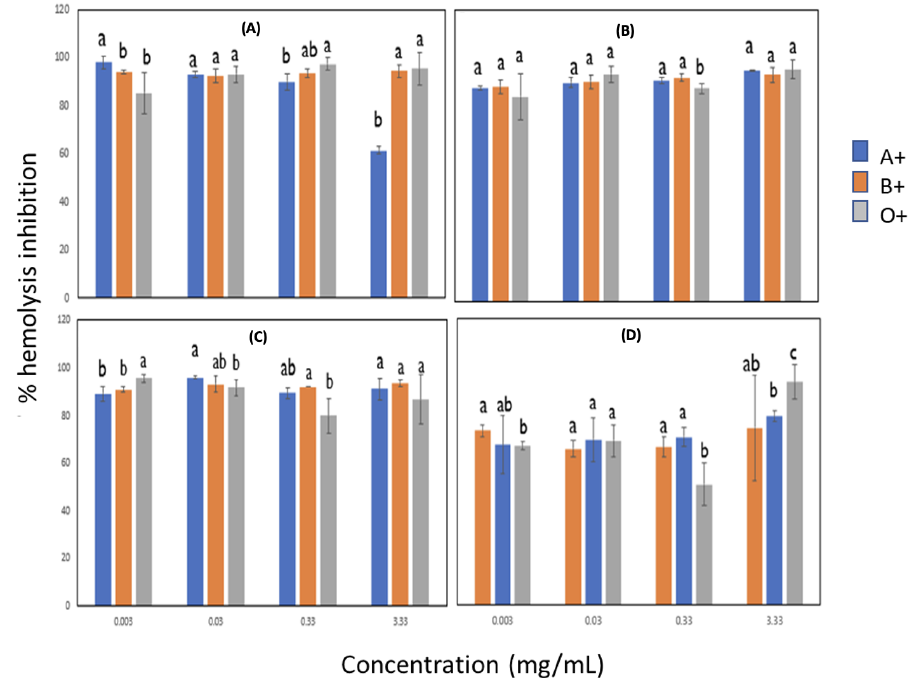
Figure 4. Effect of blood groups on anti-inflammatory activity by heat in lignin with pulsed and non-ultrasonic pulses. ( A ) Lignin with 0/0 time (min)/amplitude (MHz), ( B ) Lignin with 10/14 time (min)/amplitude (MHz), ( C ) Lignin with 10/18 time (min)/amplitude (MHz), ( D ) Lignin with 10/20 time (min)/amplitude (MHz). Different letters indicate significant difference ( p < 0.05).